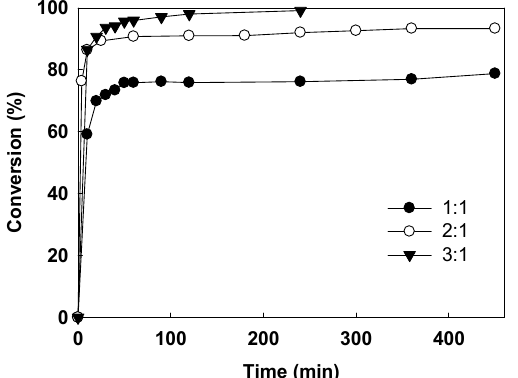
Figure 11. Effect of alcohol molar ratio. Reaction conditions: 1% Ti(IV) isopropoxide and 160 °C.